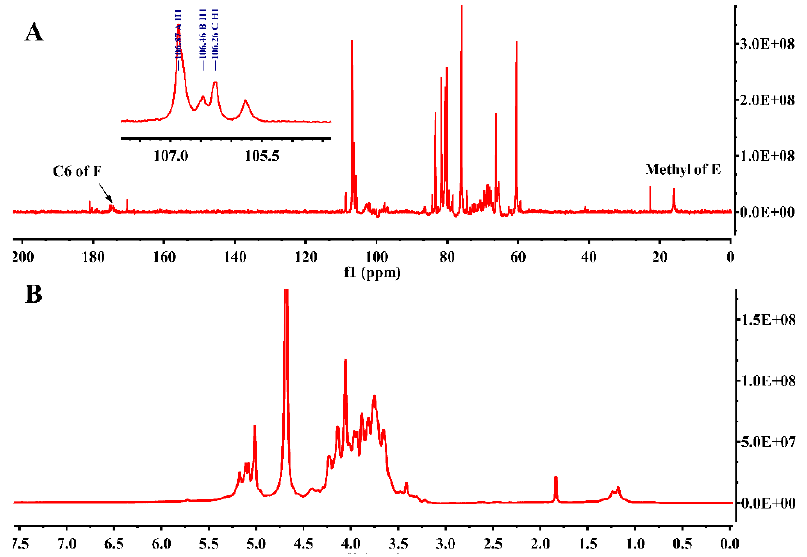
Figure 3. The 13 C NMR spectrum ( A ) and 1 H NMR spectrum ( B ) of JC-PS1.